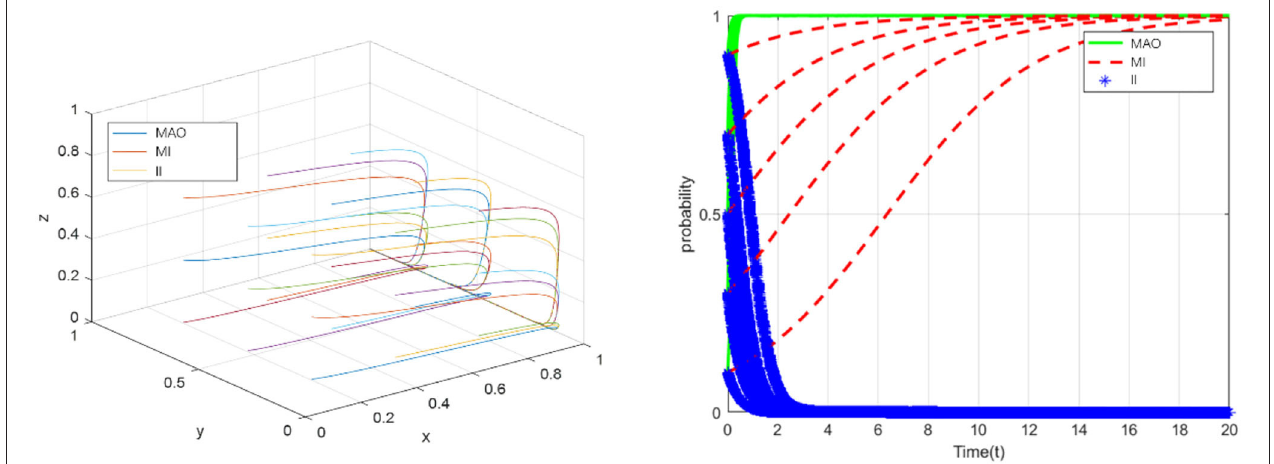
FIGURE 4 | The evolution toward the sink ESS